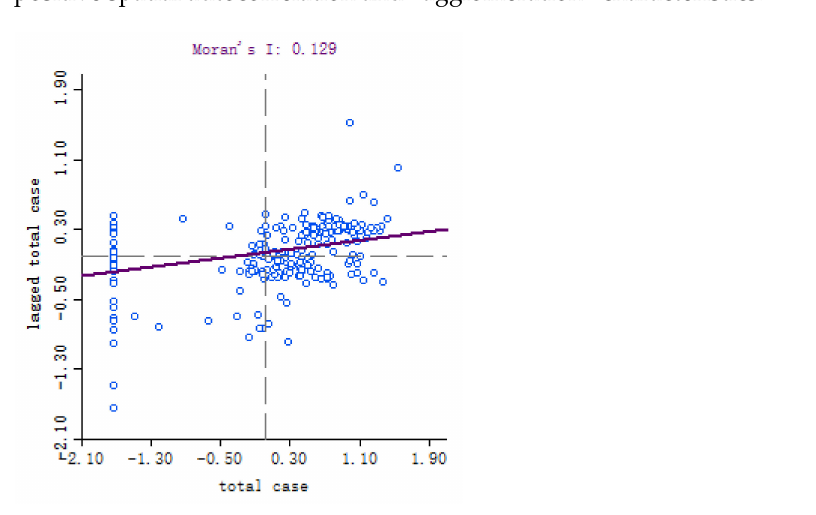
Figure 3. Moran’s I scatter plot of the cumulative number of COVID-19 on 8 April